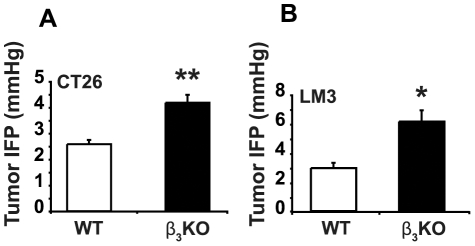
Interstitial fluid pressure (IFP) in CT26 and LM3 carcinomas.
A) CT26 carcinomas. Data are from combined experimental series (n = 24 for WT; n = 21 for integrin β3-deficient mice). ** indicates p<0.001 by Student's t-test. Error bars are SEM. B) LM3 carcinomas. Data are from one experiment (n = 6 per genotype). * indicate p<0.05 by Mann-Whitney test. Error bars are SEM.